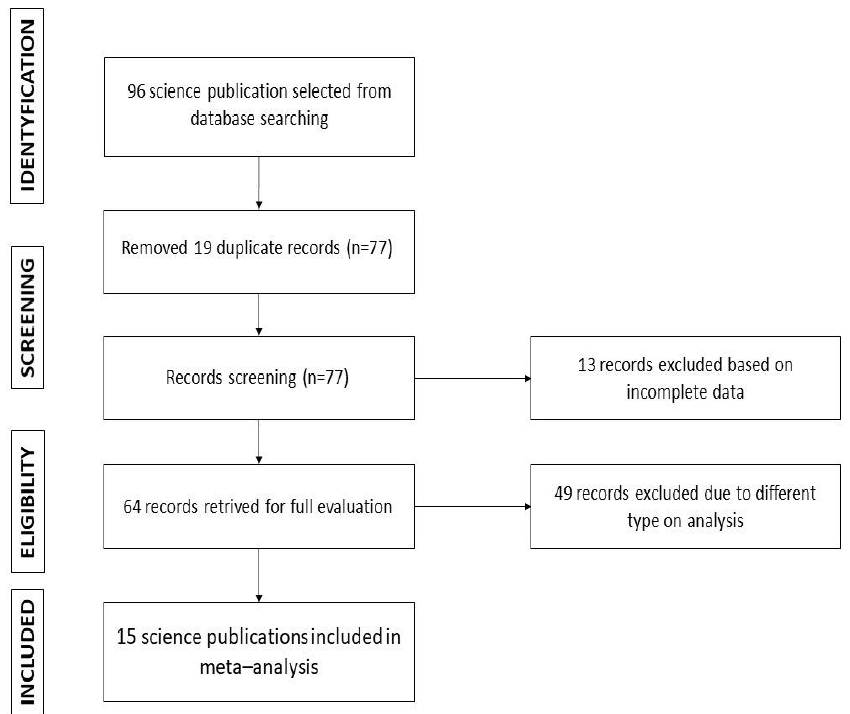
Figure 1. PRISMA flowchart describing the study design. Table 1. Characteristics of the studies, included in this